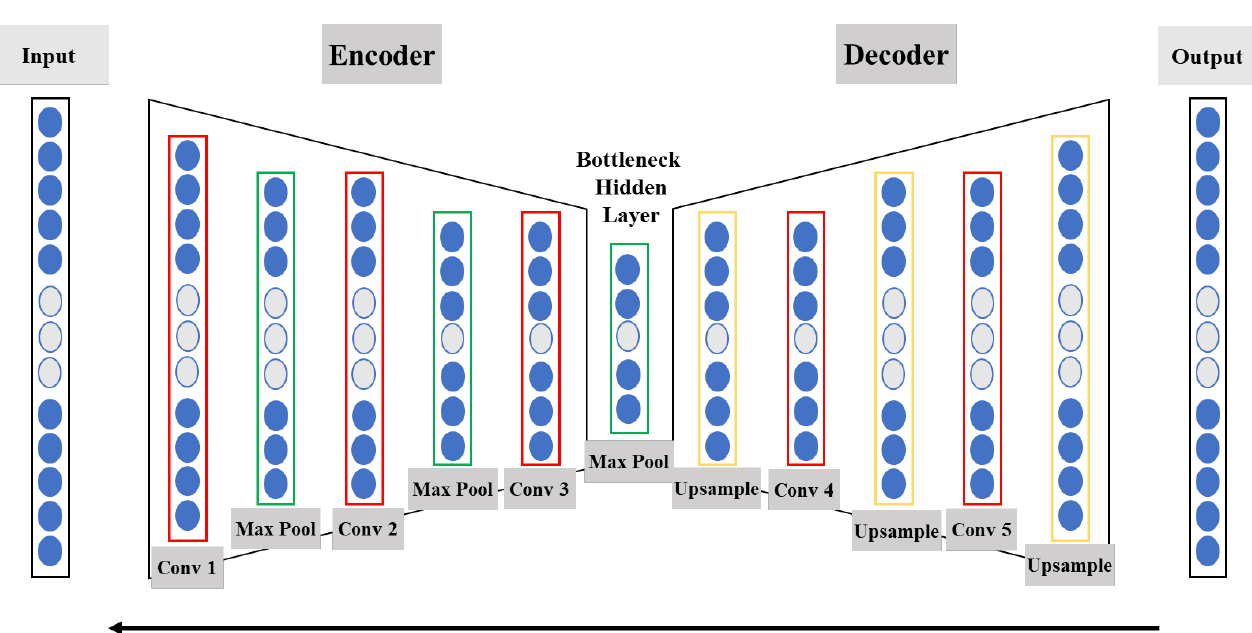
Figure 7. The sample flaw signals of every flaw types in the specimens: ( a ) the A-scan crack signal; ( b ) the A-scan lack of fusion signal; ( c ) the A-scan slag inclusion signal; ( d ) the A-scan porosity signal; ( e ) the A-scan incomplete penetration signal.